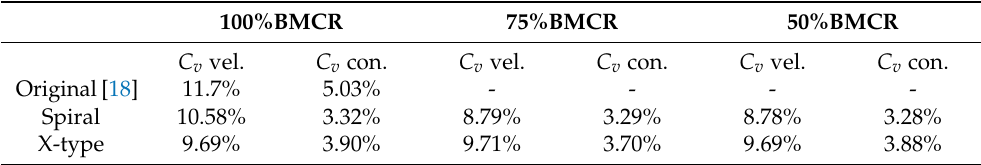
Table 3. Performance comparison table of denitration systems under various working